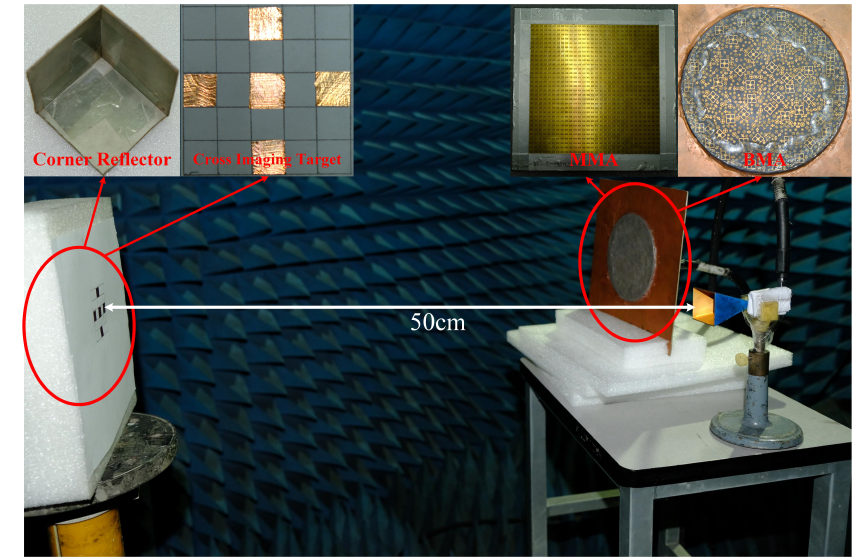
Figure 8. Coincidence imaging experiments. MMA, metamaterial aperture